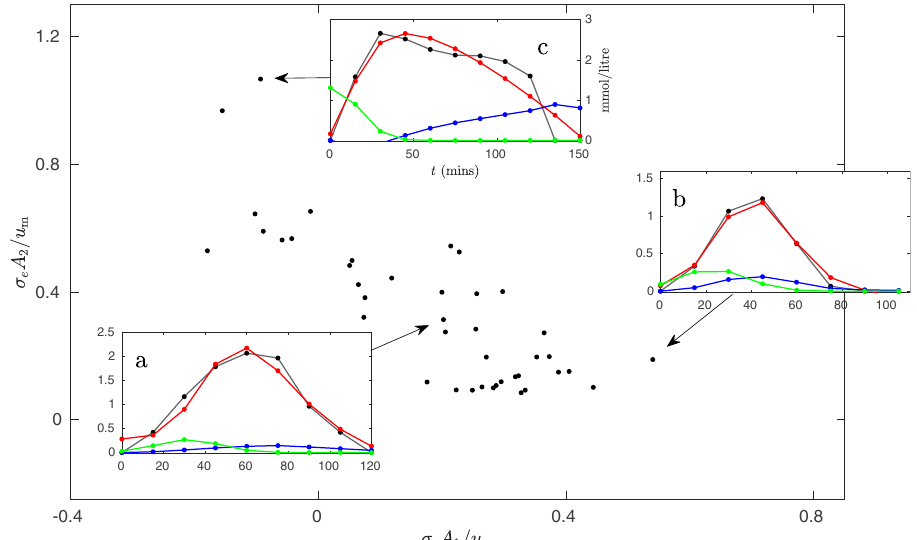
Fig. 2 Scatter plot of the optimal model parameters for all subjects. Shown are A 1 and A 2 , nondimensionalized by the standard deviation of each subject's time series of the glucose level, σ e , and the corresponding maximum of the control variable, u m . Three illustrative results of the fi tting procedure are shown in inlays. In these, the black lines correspond to the representative peaks and the red lines to the output e ( t ) of the control model (1 – 3). The normalized input function, F ( t )/ λ , and the normalized control variable, σ e u ( t )/ λ , are shown in green and blue,